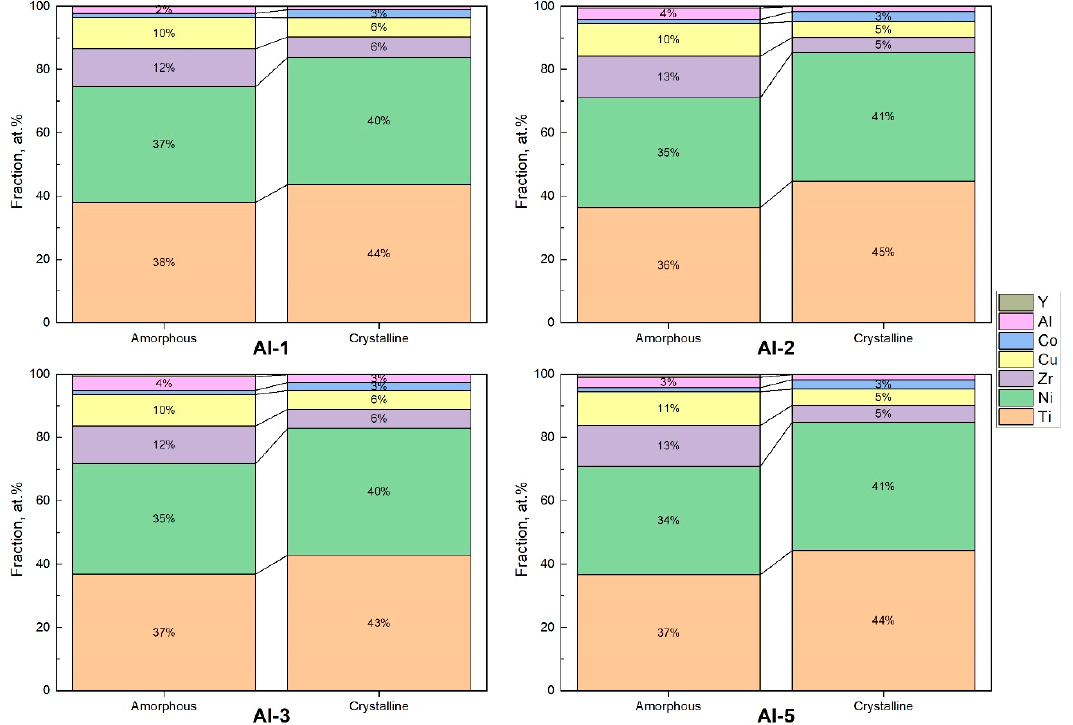
Figure 3. Chemical composition of amorphous and crystalline phases studied by EDX for alloys with Al addition (in atomic percentages) .